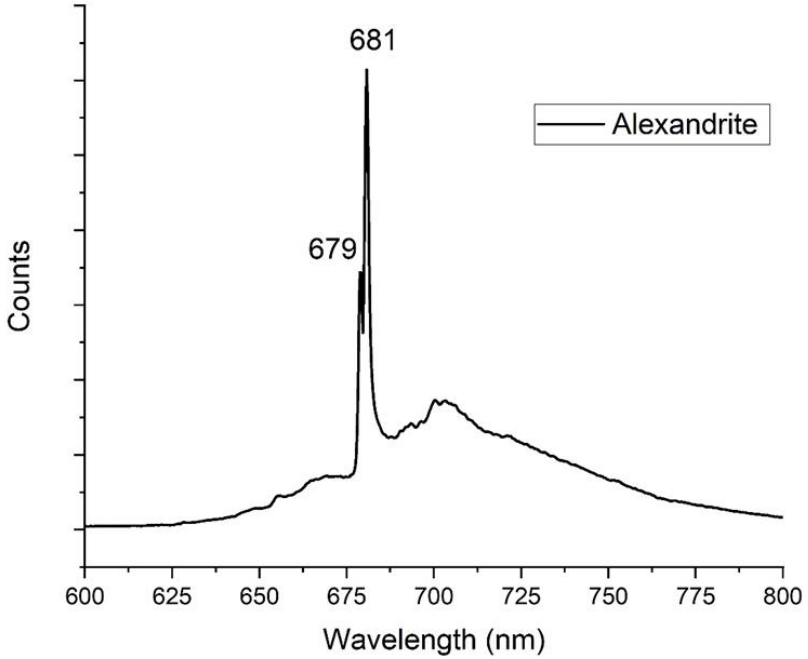
Figure 2. Photoluminescence spectra of alexandrite.